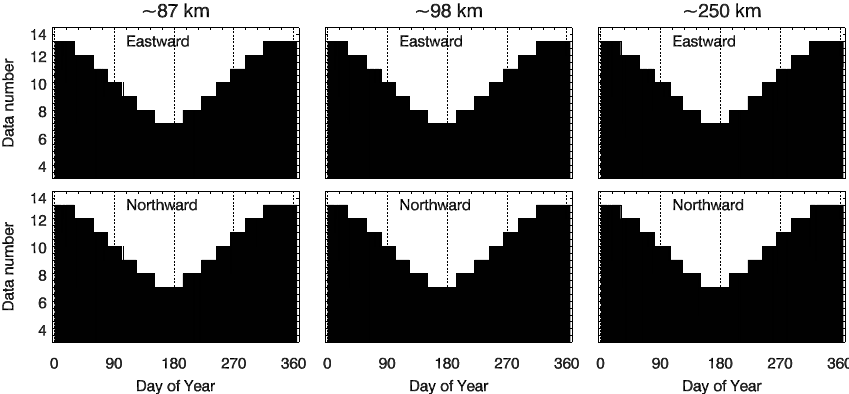
Fig. 2. Distributions of the valid data numbers in zonal and meridional winds in each night at the three airglow layers after binning all the data into one year with respect to the day